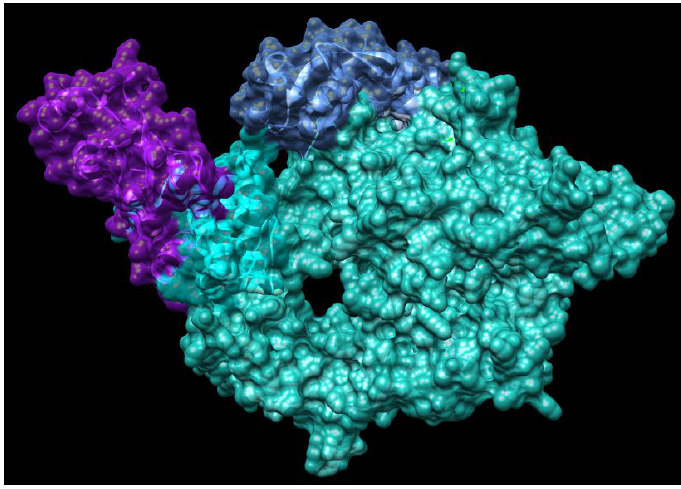
Figure 3. Structure of SARS-Coronavirus RNA polymerase NSP12 complex with NSP7 and NSP8 co-factors (PDB: 6NUR). Chain A is highlighted in light sea green, chain B is shown as blue, chain C is highlighted in cyan, chain D is highlighted in purple.